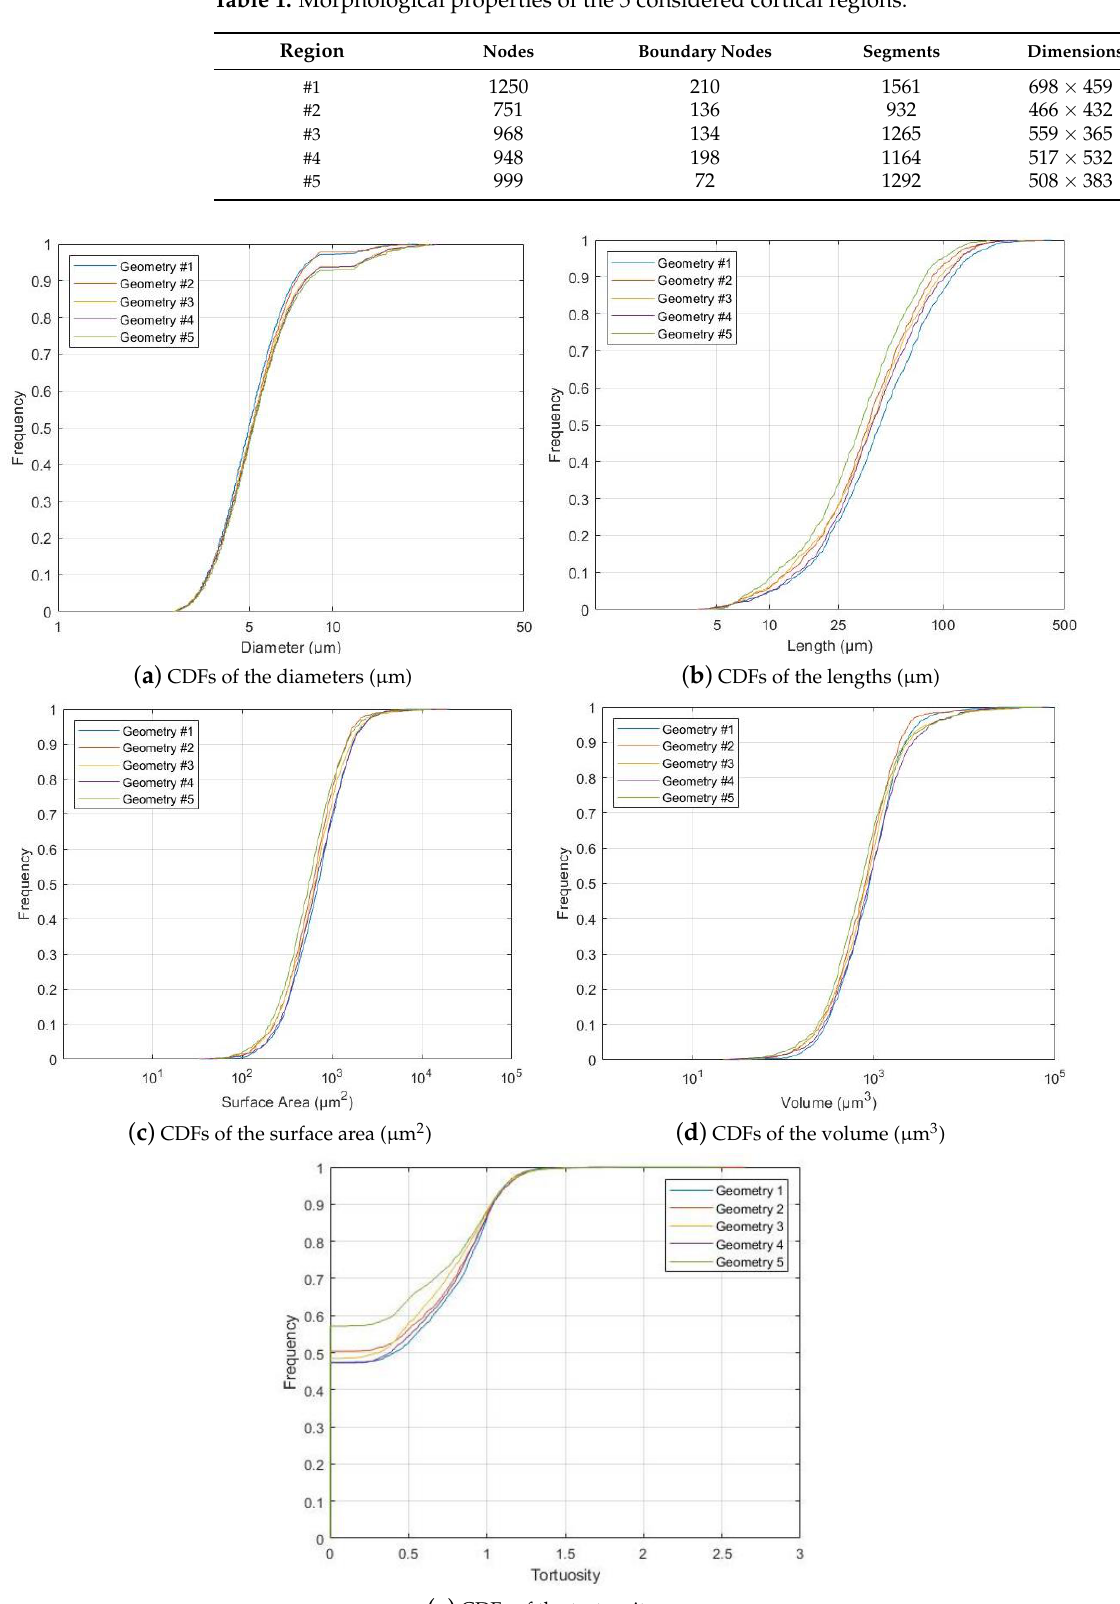
Figure 6. Statistical analysis of the considered regions: cumulative distribution functions of diameters ( a ), lengths ( b ), surface areas ( c ), volumes ( d ) and tortuosity ( e